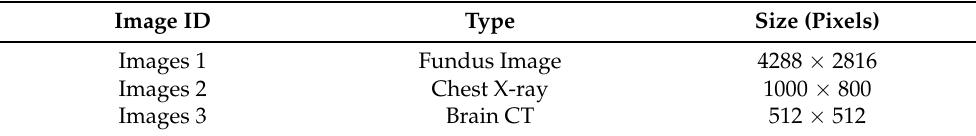
Table 2. The Images Used through Result Analysis.